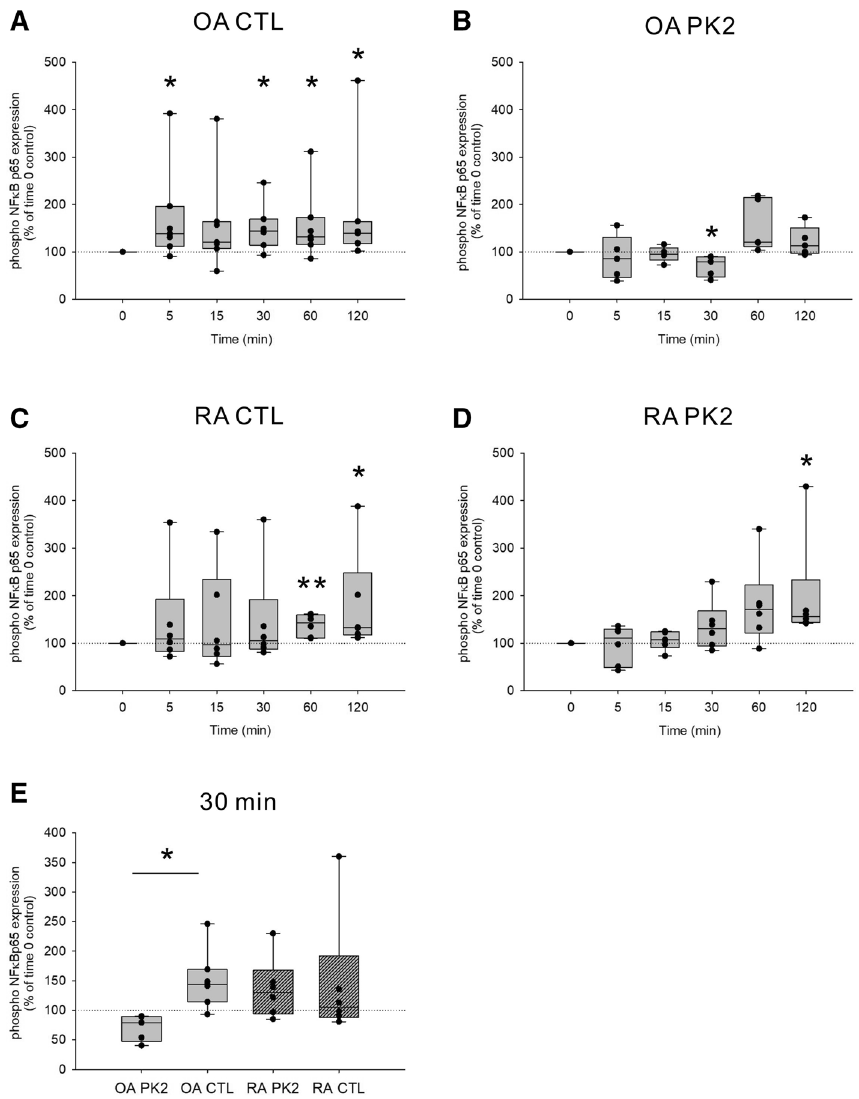
Figure 7. The induction of phospho-NFκB p65 by TNFα was attenuated in PK2 prestimulated OA-SF. Phospho-NFκB p65 protein in PK2 (10 –11 M) or control (water) prestimulated OA- or RA-SF was examined by cell-based ELISAs 0, 5, 15, 30, 60, and 120 min after stimulation with TNFα (10 ng/ml). ( A ) Control prestimulated OA-SF. ( B ) PK2 prestimulated OA-SF. ( C ) Control prestimulated RA-SF. ( D ) PK2 prestimulated RA-SF. ( E ) Comparisons of phospho-NFκB p65 expression between PK2 or control prestimulated OA- or RA-SF 30 min after stimulation with TNFα. N = 5–8. Data were given as box plots, the description of which is given in the legend to Fig. 2. Each dot in the figure represents a different cell line derived from a different patient. For statistical analysis, the one-sample Wilcoxon signed-rank test was used for comparisons with time 0 as the control, representing the 100% line. In comparisons among the groups at 30 min after stimulation with TNFα ( E ), the Mann–Whitney test was used. *p < 0.05, **p < 0.01. NFκB nuclear factor kappa-light-chain-enhancer of activated B cells, PK2 prokineticin 2, CTL control, OA osteoarthritis, RA rheumatoid arthritis, SF synovial fibroblasts, TNFα tumor necrosis factor